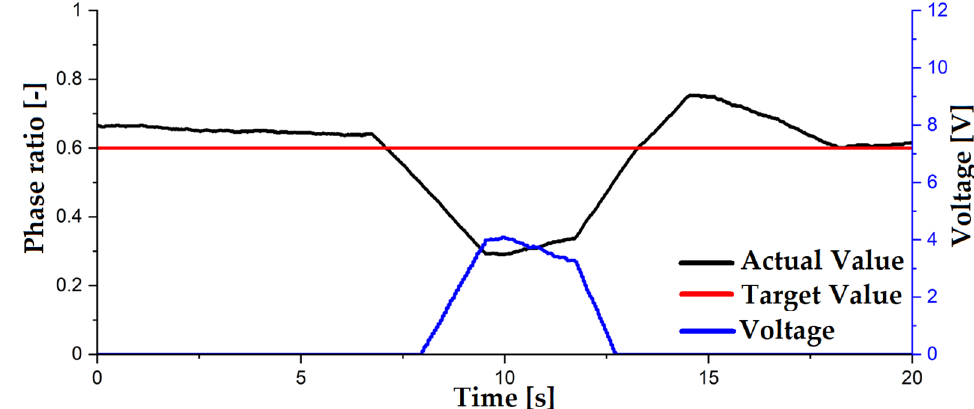
Figure 9. Dynamic actions of the actual and setpoint value of the phase ratio and voltage .